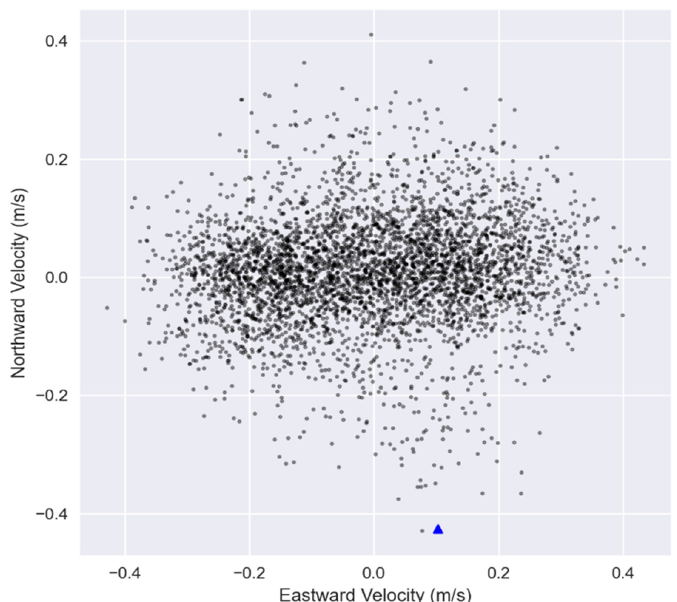
Figure 5. The scatter plot of the hourly observed near-bottom currents at a site in the northern reef (open circle, Figure 1) for half a year. The maximum hourly current is depicted by the blue triangle.